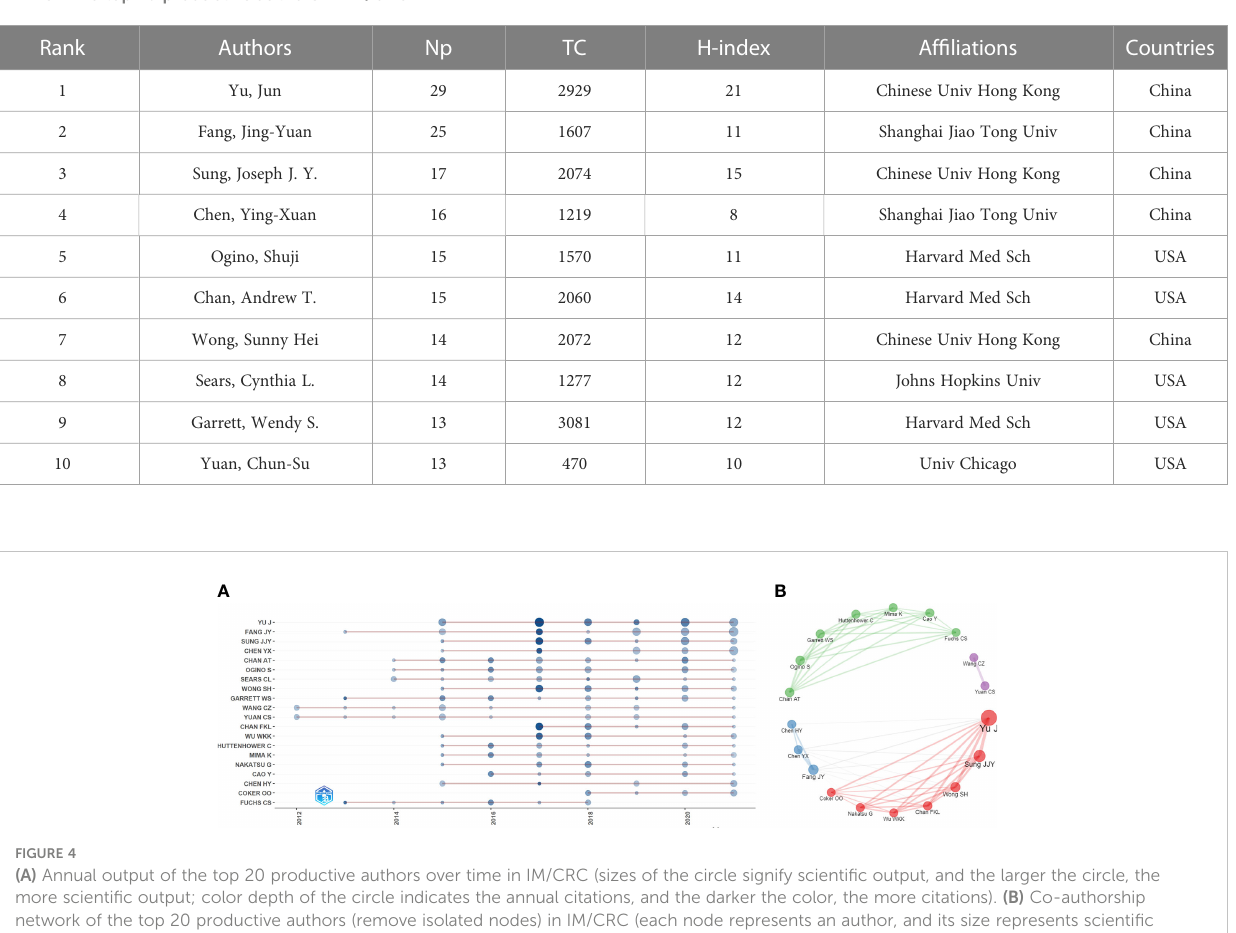
TABLE 3 The top 10 productive authors in